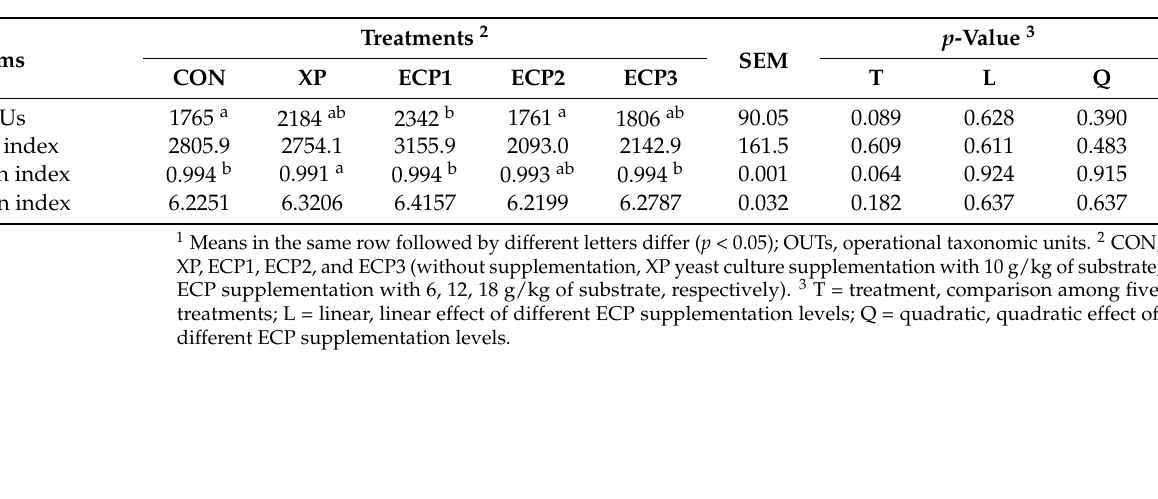
Table 5. The sequencing data information and alpha diversity analysis 1